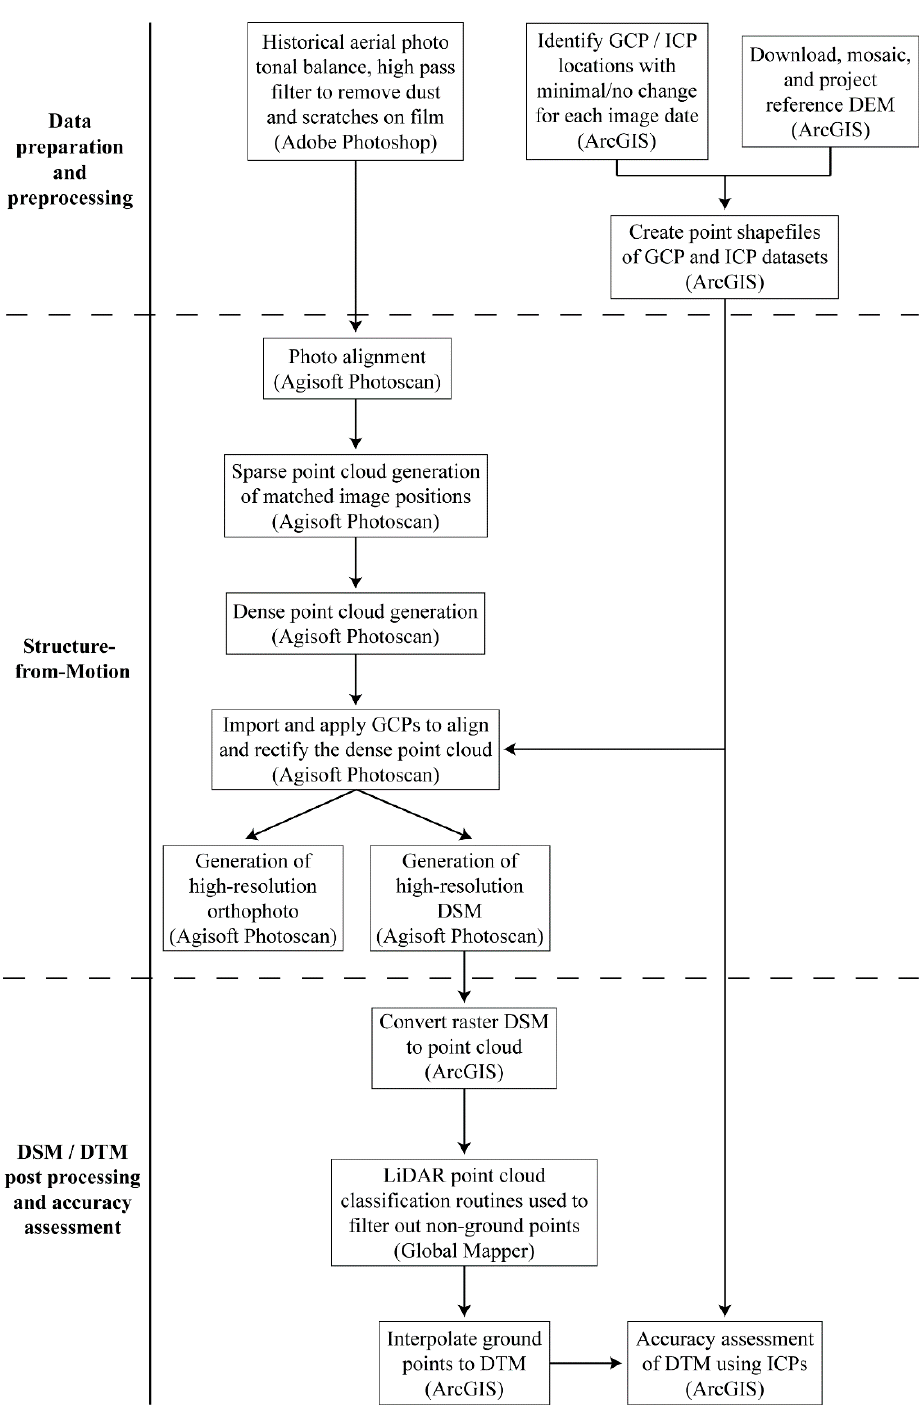
Figure 3. Graphical diagram showing the general processing steps of the methodology.